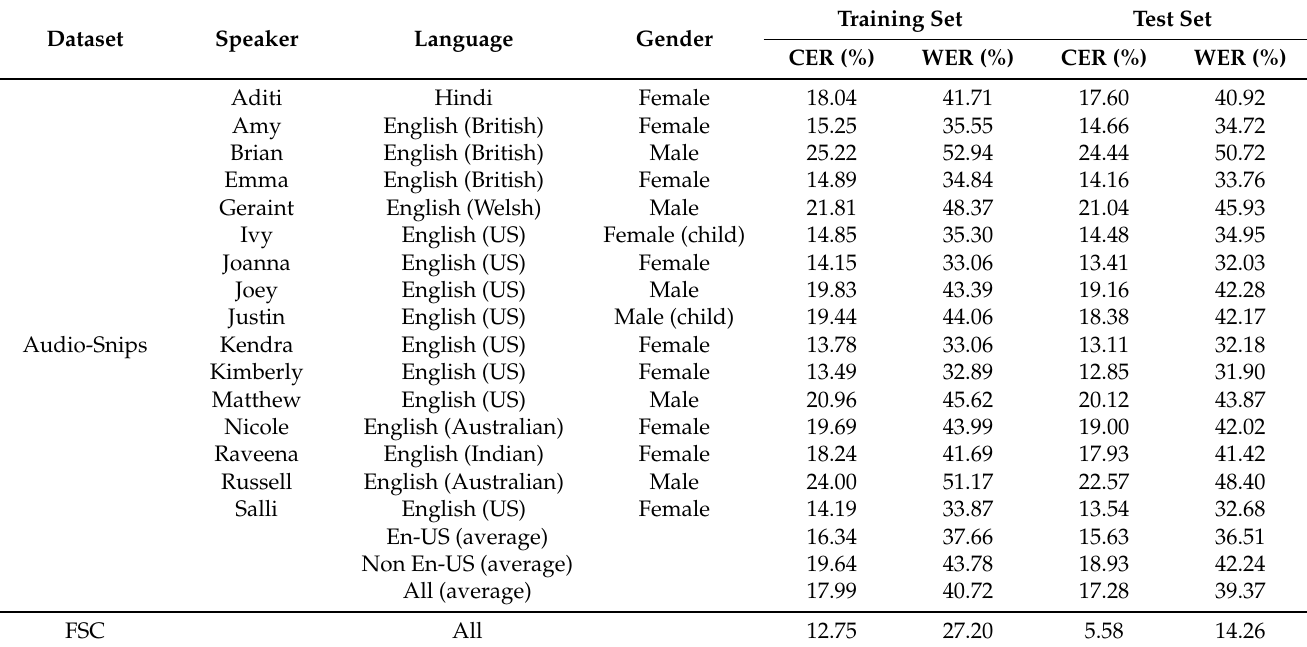
Table 1. Observations of both CER and WER of Audio-Snips and FSC dataset, respectively. The lower the CER and WER means the better performance of the ASR. Note that both CER and WER are measured without punctuation (e.g., !, ?, .,